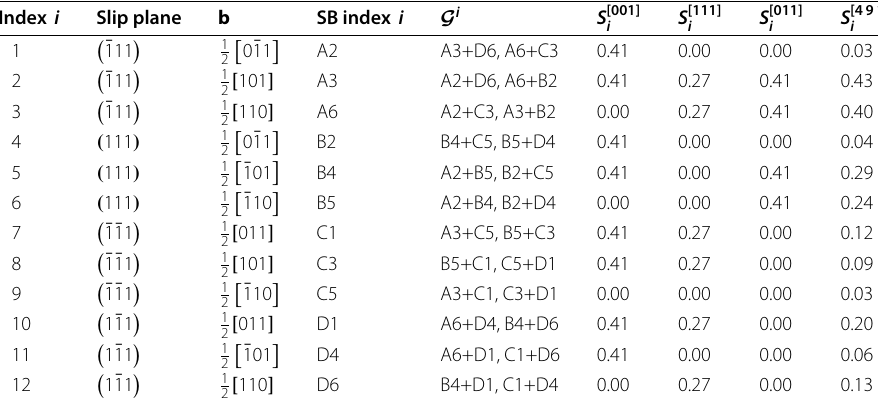
Table 1 Slip systems in FCC crystals with their slip plane and Burgers vector b and their Schmid-Boas (SB) notation. The column G i lists glissile reactions between slip-system pairs that produce a dislocation on slip system i . Also listed are the Schmid factors S i for four loading orientations: [ 0 0